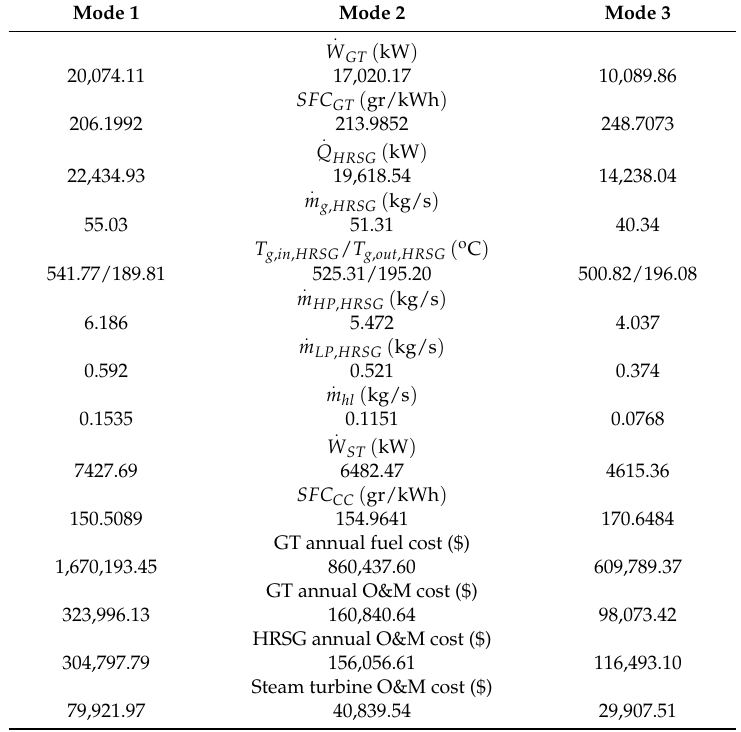
Table 10. Operational technical and economic characteristics for the system with gas turbine type (a) and fuel